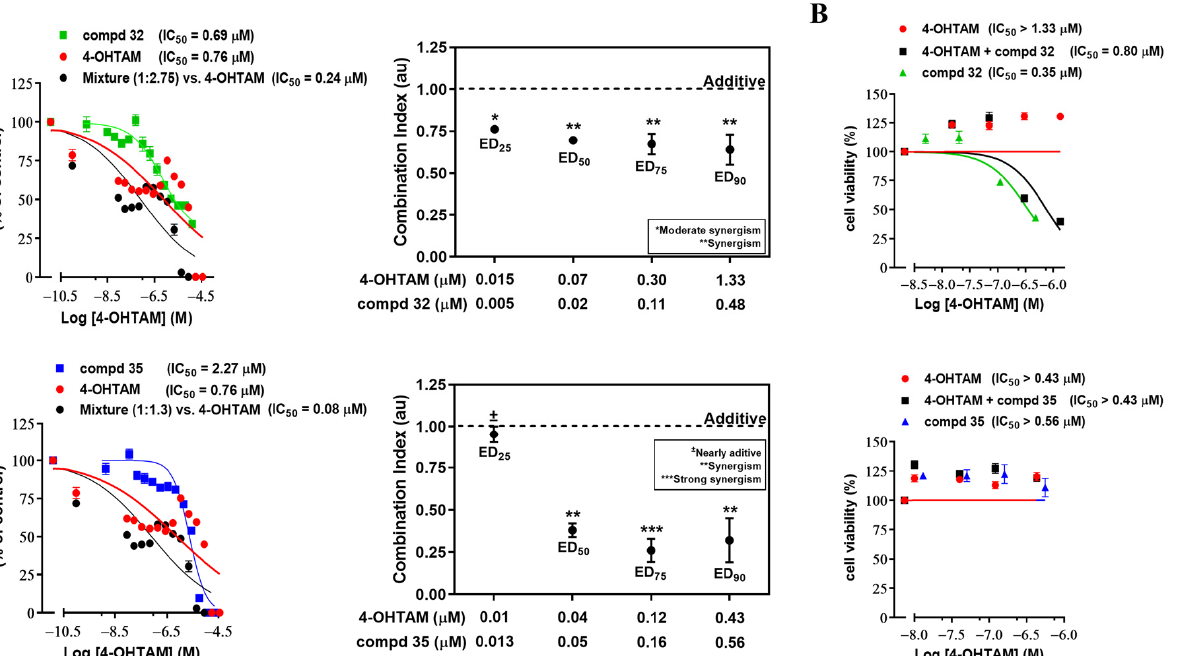
Figure 15. A combination of 5-hydroxy-2 H -pyrrol-2-ones 32 and 35 with 4-OHTAM promote syn- ergistic antitumoral effects in human ER+ breast cancer cells with scarce or null effects in human non-malignant breast cells. ( A ) Cell viability inhibition was measured in MCF-7 cells. Left panel : MCF-7 cells were treated with compounds 32 ( (cid:4) ; 0.0004–12.8 µ M), 35 ( (cid:4) ; 0.0014–22.4 µ M) 4-OHTAM ( • ; 0.001–35.2 µ M) or with the respective combination of compound-4-OHTAM ( • mixture) maintaining a constant ratio [compound 32 :4-OHTAM (1:2.75)] or [compound 35 :4-OHTAM (1:1.3)] for 72 h. Right panel : Isobologram analysis (determination of the combination index, CI) of the cell viability data graphed in the left panel. The effects ranged from 0 (no cell viability inhibition) to 1 (100% viability inhibition) and were analyzed using Calcusyn ® software, as described in the Material and Methods. Data are representative of two independent experiments, where each treatment was tested in four replicates. CI values (mean ± SEM) for ED 25 , ED 50 , ED 75 and ED 90 express additive ( ± ) or different grades of synergistic (*, **, ***) effects. ( B ) Cell viability inhibition was measured in MCF-10A cells. Cells were treated with: compound 32 ( (cid:78) ; 0.005–0.48 µ M), 4-OHTAM ( • ; 0.015–1.33 µ M) or its combination; or compound 35 ( (cid:78) ; 0.013–0.56 µ M), 4-OHTAM ( • ; 0.01–0.43 µ M) or its combination, according to the CI values (mean ± SEM) for ED 25 , ED 50 , ED 75 and ED 90 calculated in panel A. Cell viability were assessed after 72 h treatment by MTT assays as described in Materials and Meth- ods. Non-linear regression analysis was applied with GraphPad Prism software 8.4.3 to calculate IC 50